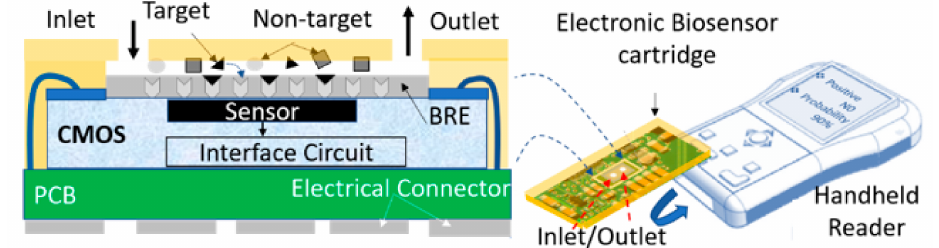
Figure 1. Schematic view of fully integrated CMOS-based PoC system including an electronic disposable cartridge and a reader: CMOS biosensor features a CMOS sensor and circuit, BRE layer, and microfluidic with